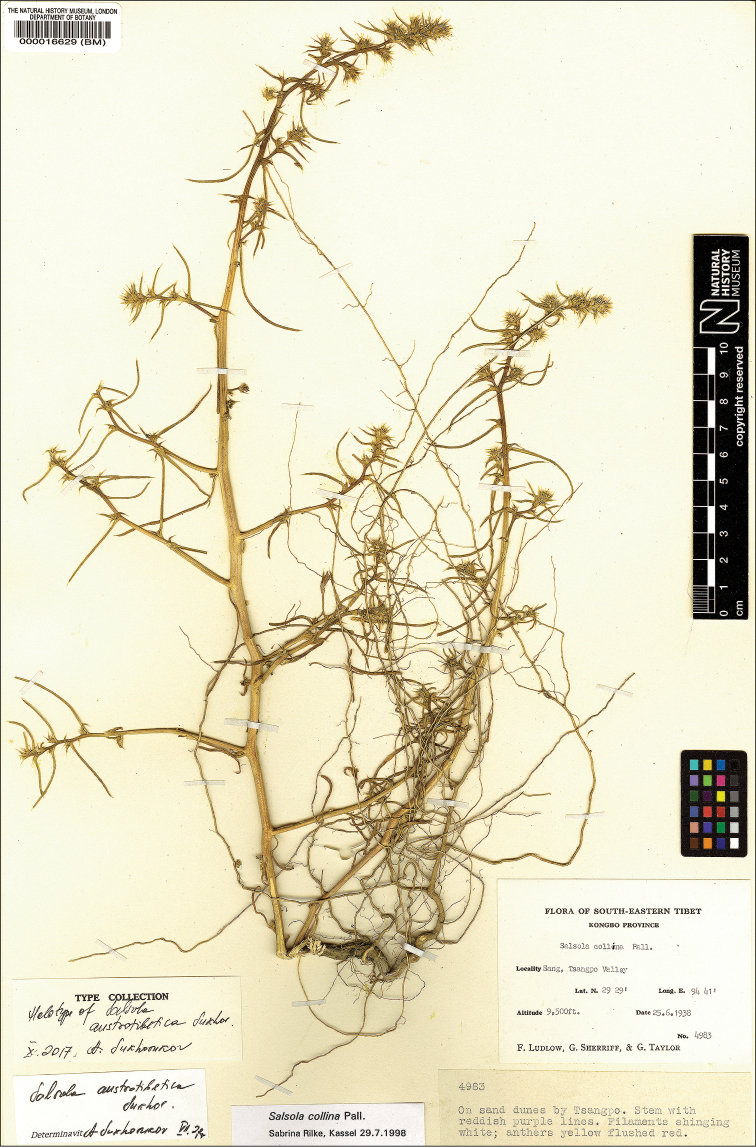
Holotype of Salsolaaustrotibetica Sukhor. sp. nov. (BM0000016629).